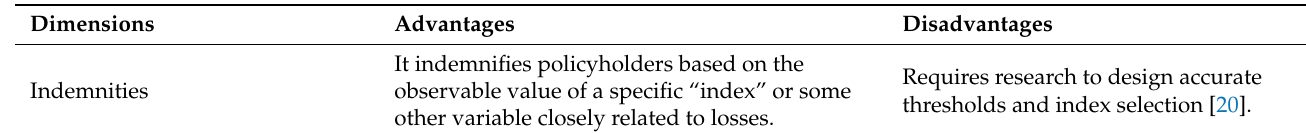
Table 1. Summary of advantages and disadvantages of index insurance. Sources: Abdi et al.